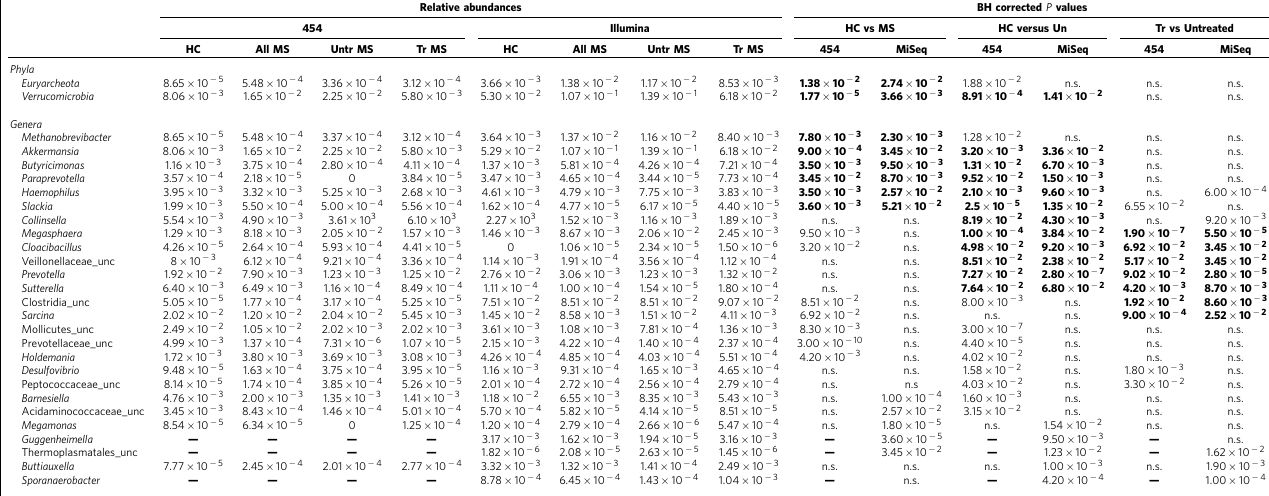
HC, healthy controls; MS, multiple sclerosis; unc, unclassified; Untr, untreated MS patients; Tr, treated MS patients. The table lists taxa that differ between HC and MS patients, between HC and Untr and between untreated and Tr, detected on two different sequencing platforms, 454 and MiSeq. Significant differences weretestedbyDESeq,and P valueswereadjustedbytheBenjamini–Hochbergmethod.Relativeabundancesarelisted.Valuesthataresignificant( P o 0.05)onbothplatformsareinbold.Taxaarelistedat the genus level or at their lowest possible level of classification, followed by unc. Genera that were not detected on a given platform are indicated with a ( — ). Non-significant P values are listed as